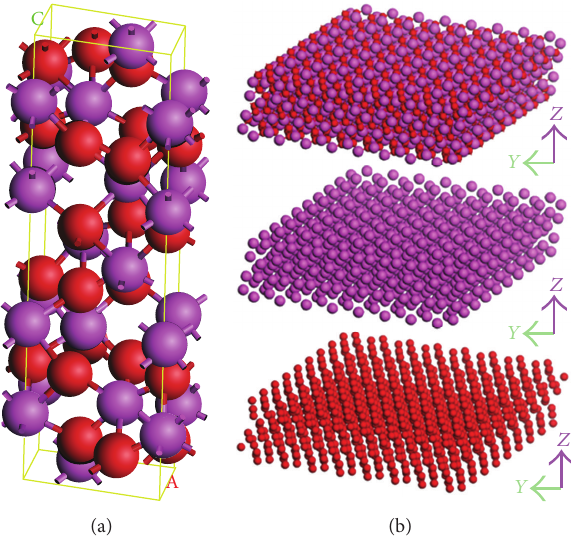
Figure 1: Crystal structure of 𝛼 -alumina. (a) The crystal structure cell, 𝑎 = 0.4759 nm, 𝑏 = 0.4759 nm, and 𝑐 = 1.2991nm; (b) the crystal structure of 𝛼 -alumina, the oxygen atom cluster and aluminum atom